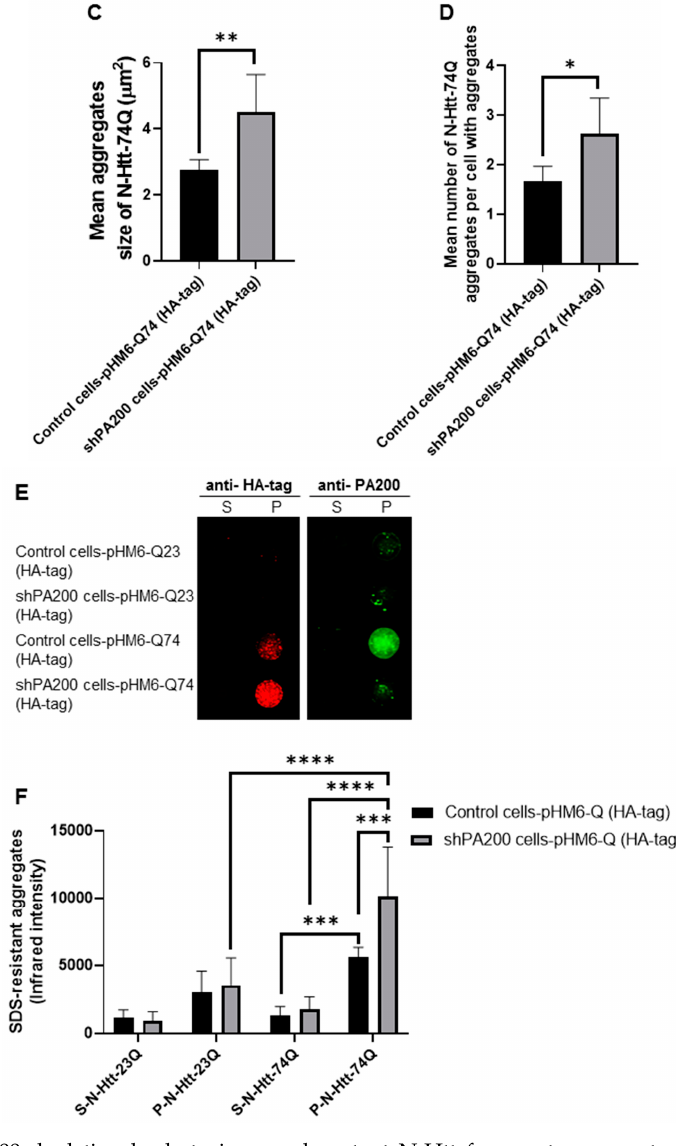
Figure 5. PA200 depletion leads to increased mutant N-Htt fragments aggregate size and number. ( A , B ) Representative confocal microscopy images of wt and mutant N-Htt fragments in control and PA200-depleted neuroblastoma human cells are shown. White squares represent the corresponding insets (lower panels); arrows indicate the toxic Htt aggregates. Control and shPA200 cells were transfected with pHM6-Q23 (with HA-tag) and pHM6-Q74 (with HA-tag) constructs for 48 h. The cells were immunolabeled with HA-tag antibody followed by Alexa Fluor 594 secondary antibody (Red). ( C , D ) Aggregate size and number were determined from the confocal microscopy images using ImageJ software (imagej.nih.gov). The data are presented as mean ± SD obtained from 1057 control cells and 1207 shPA200 cells from five independent experiments. Statistical analysis was carried out using unpaired Student’s t -test with GraphPad Prism v. 8.2.1 software (* indicates p < 0.05; ** indicates p < 0.01). ( E ) Representative images of filter trap immunoblots of SDS-resistant aggregates and PA200 protein. After 48 h transient transfection with pHM6-Q23(HA-tag)orpHM6-Q74(HA-tag), controlandshPA200cellswerelysedwithfiltertraplysisbuffer. Equal supernatant (S) and pellet (P) protein amounts (10 µ g) from control and shPA200 cells were loaded onto 0.2 µ m nitrocellulose membrane then probed with HA-tag and PA200 antibodies. Antigen–antibody complexes were detected using infrared fluorescent dye (IRDye 700 Red for HA-tag and IRDye 800 Green for PA200) secondary antibodies. Dot blots were visualized with the LI-COR Odyssey infrared imaging system. ( F ) Quantification of SDS-resistant aggregates detected by filter trap assays of control and shPA200 cells is shown. Data are shown as mean ± SD of four independent experiments. Statistical analysis was accomplished by ANOVA test using GraphPad Prism v. 8.2.1 software (*** indicates p < 0.001; **** indicates p <